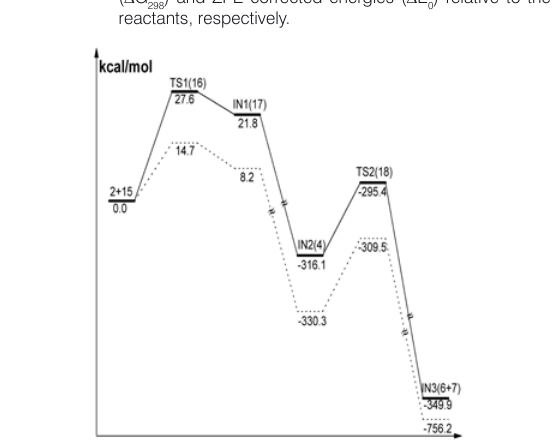
) relative to the 0